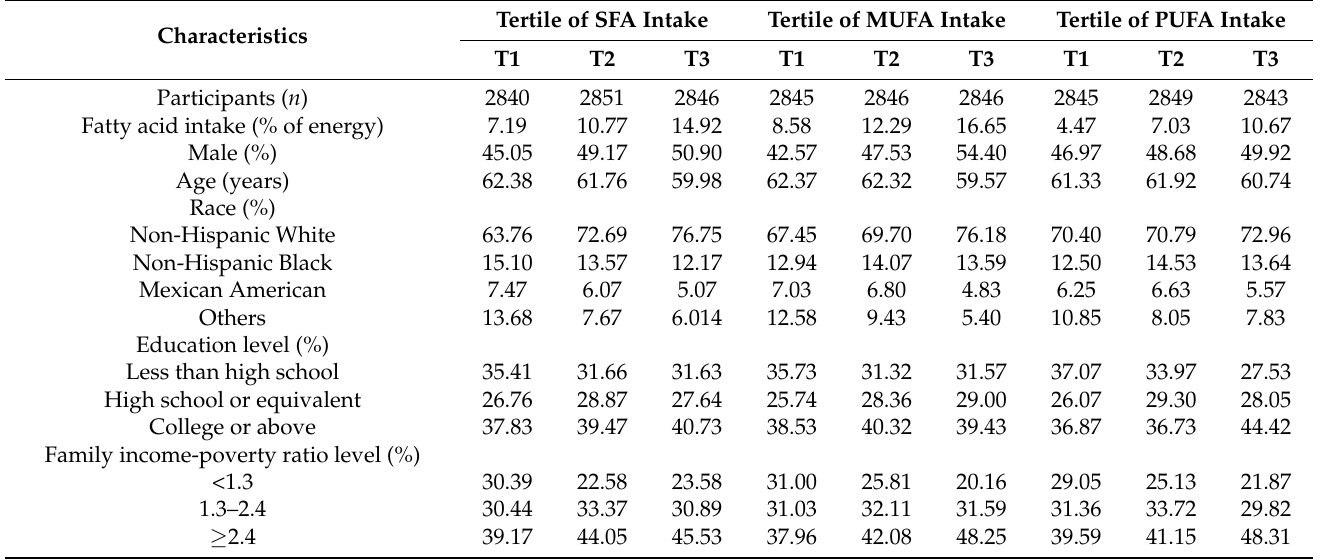
Table 1. Baseline characteristics of patients with cardiometabolic diseases in NHANES III and NHANES 1999–2014 according to the tertiles of energy percentage from SFA, MUFA, and PUFA a